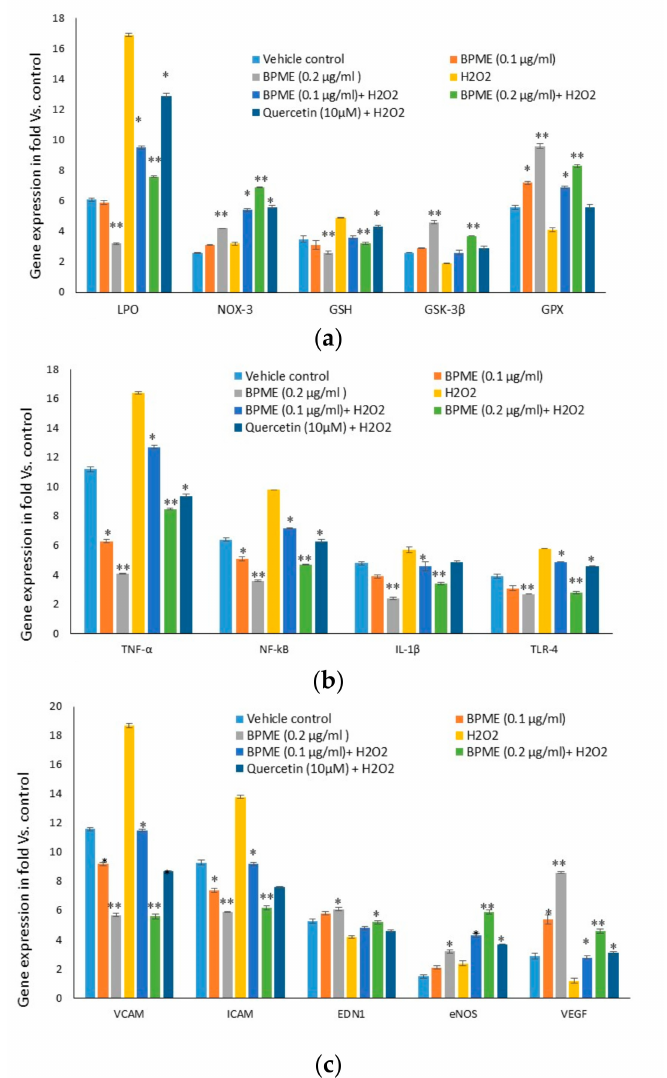
Figure 8. Oxidative stress, antioxidant ( a ), pro-inflammation ( b ) and vascular cell inflammation ( c )-related gene expression levels of vehicle control, 0.1 and 0.2 µ g/mL of beetroot peel methanol extract (BPME)-treated normal and H 2 O 2 -induced oxidative-stressed HUVECs after 48 h. All values are means ± SD ( n = 6). * p ≤ 0.05 and ** p ≤ 0.001 were compared with vehicle control or H 2 O 2 alone treated